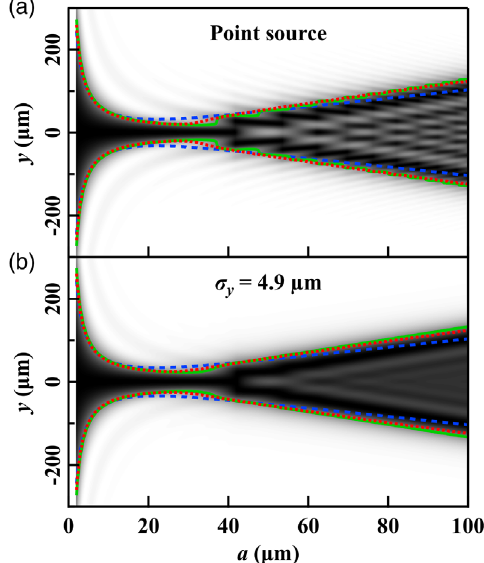
FIG. 2. Normalized diffraction profiles from a 1D slit with different a sizes simulated with Eqs. (9) – (11) for (a) a point 4 . 9 μ m (M3 source and (b) a Gaussian source with size σ y ¼ bend magnet for the Advanced Photon Source upgrade source). The grayscale is linear to the profile intensity, and a darker color indicates a higher intensity. The calculation parameters are λ ¼ 0 . 827 Å (photon energy, E ¼ 15 keV), p ¼ 6 . 6 m, and q ¼ 13 . 4 m. The dashed curves are the (cid:3) σ values obtained pinhole from Eq. (8), the solid curves are the FWHM/2.355 values of the diffraction profiles, and the dotted curves are the Gaussian fitted σ values.